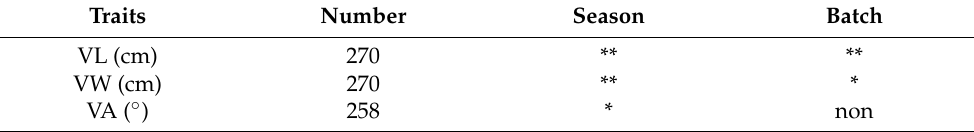
Table 1. Significance between environmental effects and vulvar traits of Suhuai pigs. Traits Number Season Batch VL (cm) 270 ** ** VW (cm) 270 ** * VA ( ◦ ) 258 * non